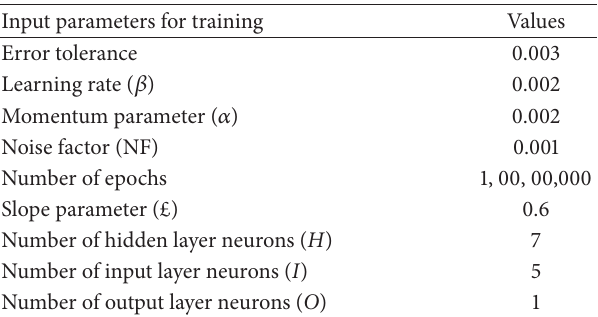
Table 4: Input parameters for training.